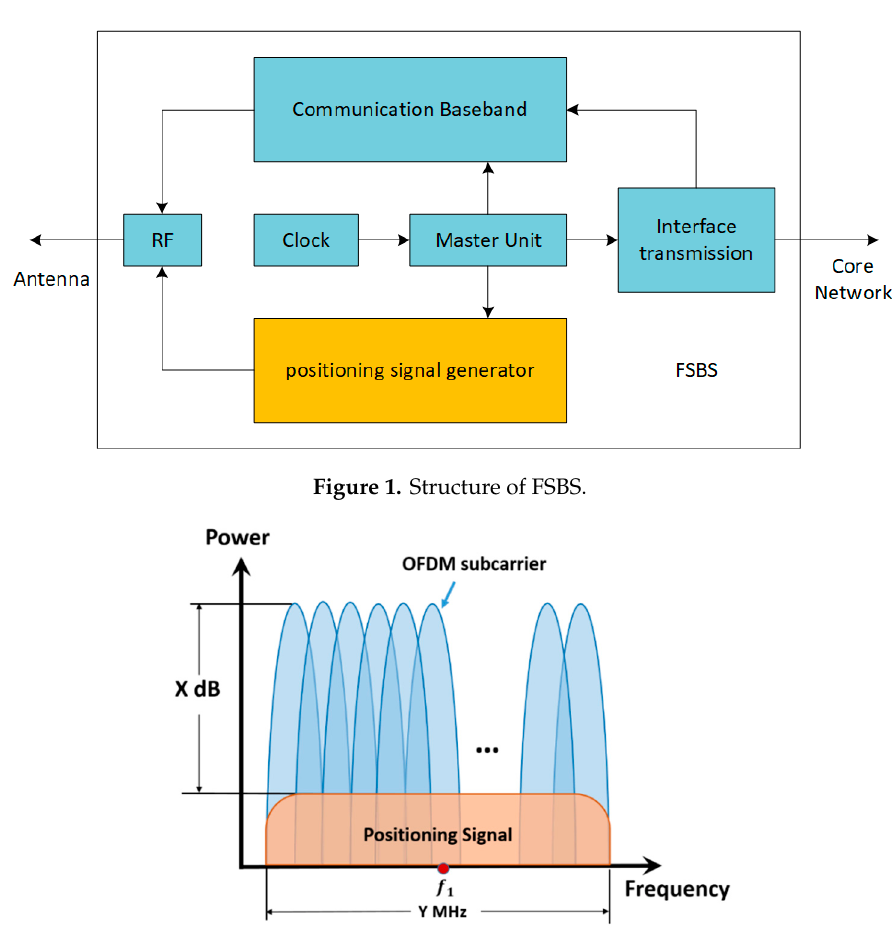
Figure 2. Schematic diagram of the process of superposing positioning signal and communication signal.